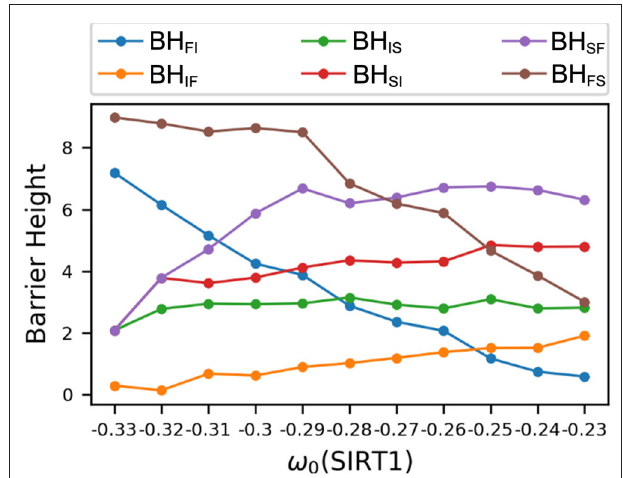
FIGURE 4 | Changes in barrier heights upon increasing the basal gene expression level of SIRT1. BH FI , barrier height from the fast-aging to the intermediate attractor; BH IF , barrier height from the intermediate to the fast-aging attractor; BH IS , barrier height from the intermediate to the slow-aging attractor; BH SI , barrier height from the slow-aging to the intermediate attractor; BH SF , barrier height from the slow-aging to